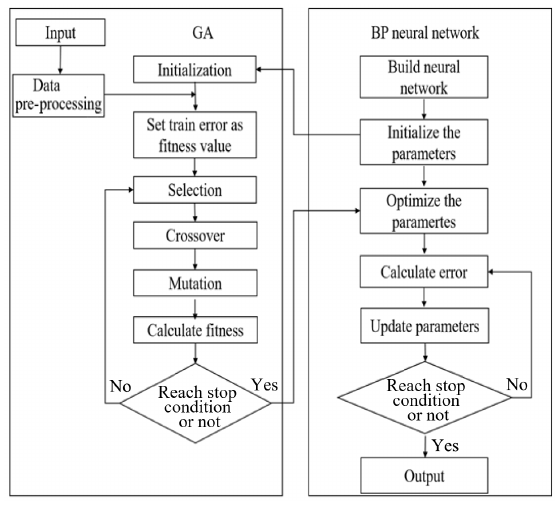
Fig. 1 Abstract illustration of